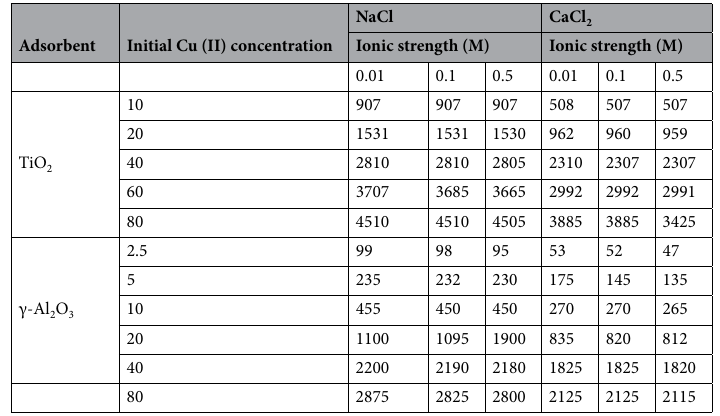
Table 5. Copper adsorption (mg kg −1 ) in the presence of NaCl and CaCl 2 as background electrolytes at various ionic strengths.